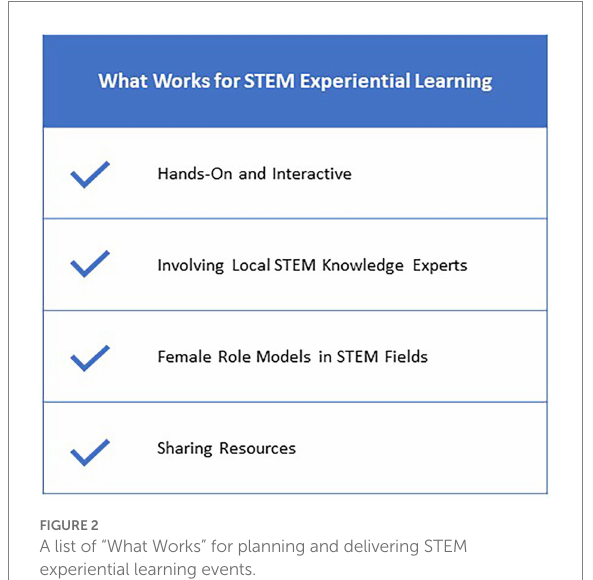
FIGURE 2 A list of “What Works” for planning and delivering STEM experiential learning